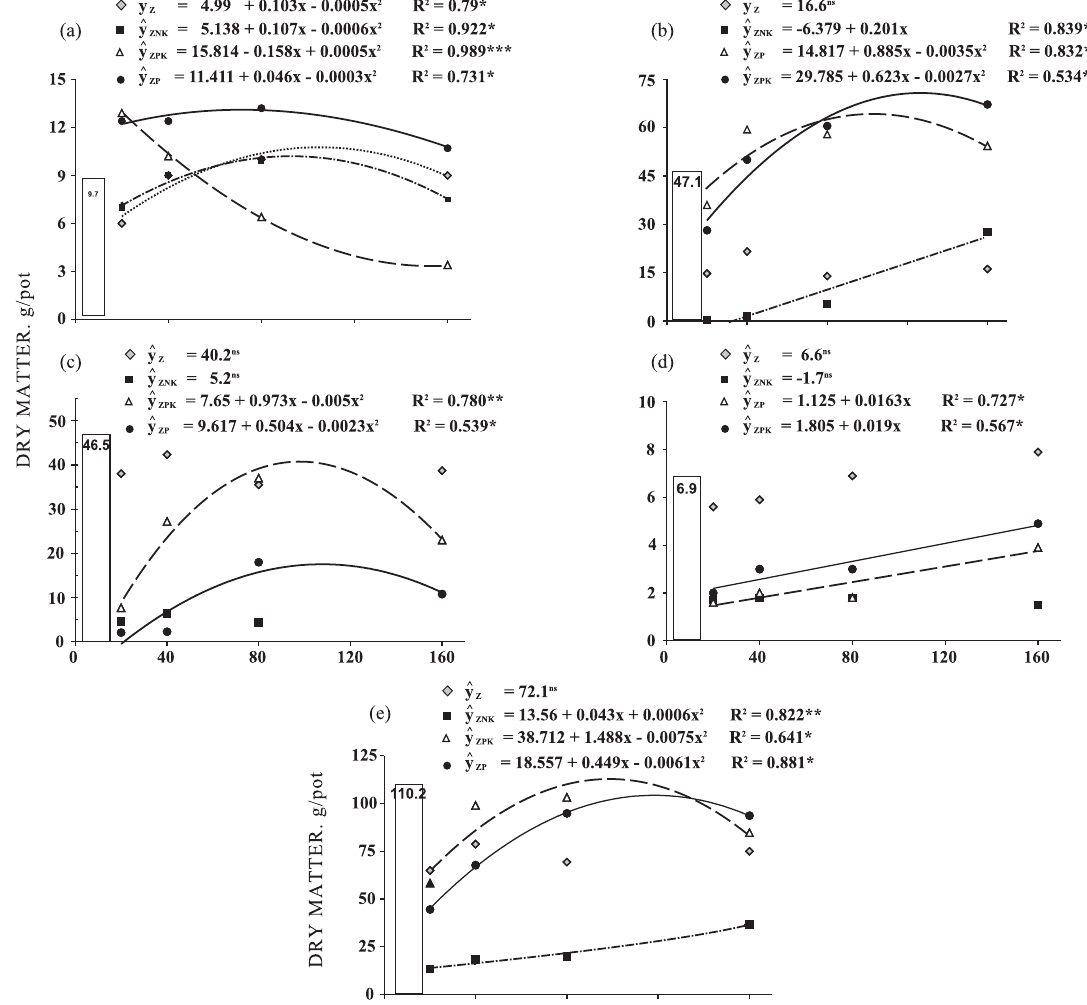
Figure 1. Dry matter yield of lettuce (a), tomato (b), rice (c) and andropogon grass (two cuts - d) and total (e) of plants grown in zeolite-enriched (Z) substrate enriched with N, P and K. The bar indicates the control mean (without